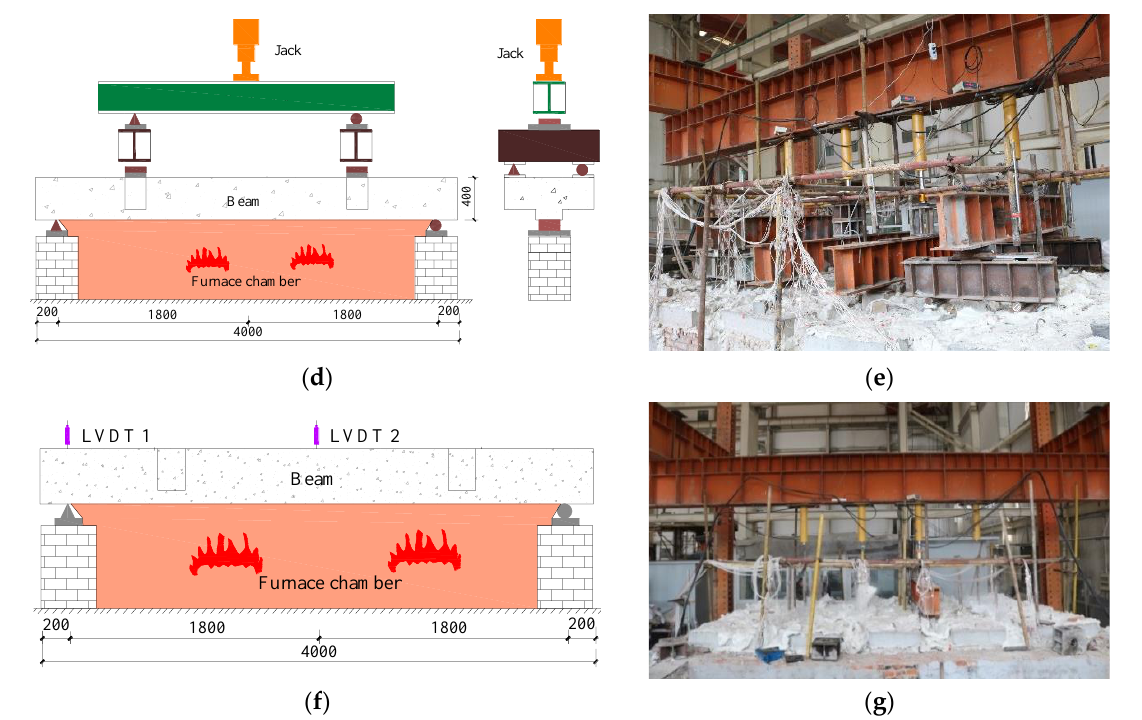
Figure 3. Fire test of beams under indirect loading (dimensions in mm). ( a ) Furnace chamber. ( b ) Beams in the furnace chamber. ( c ) Top view of the furnace. ( d ) Dimensions of the shear loading apparatus. ( e ) Fire test set-up of the preloaded beam. ( f ) Fire test of the not preloaded beam. ( g ) Fire test set-up of the not preloaded beam.